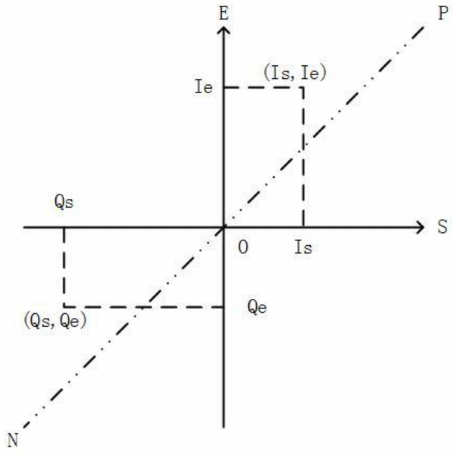
Figure 4. Interval representation in two-dimensional space [8,9]. Table 2. Interval algebra relationships